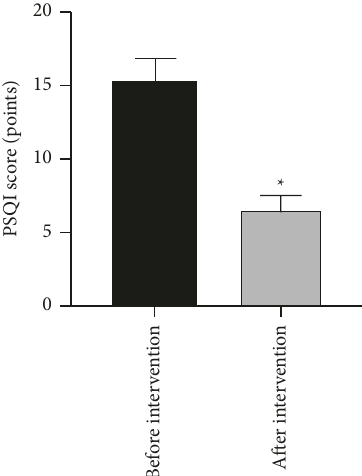
Figure 5: Comparison of sleep quality before and after intervention compared with before intervention, ∗ P < 0 .